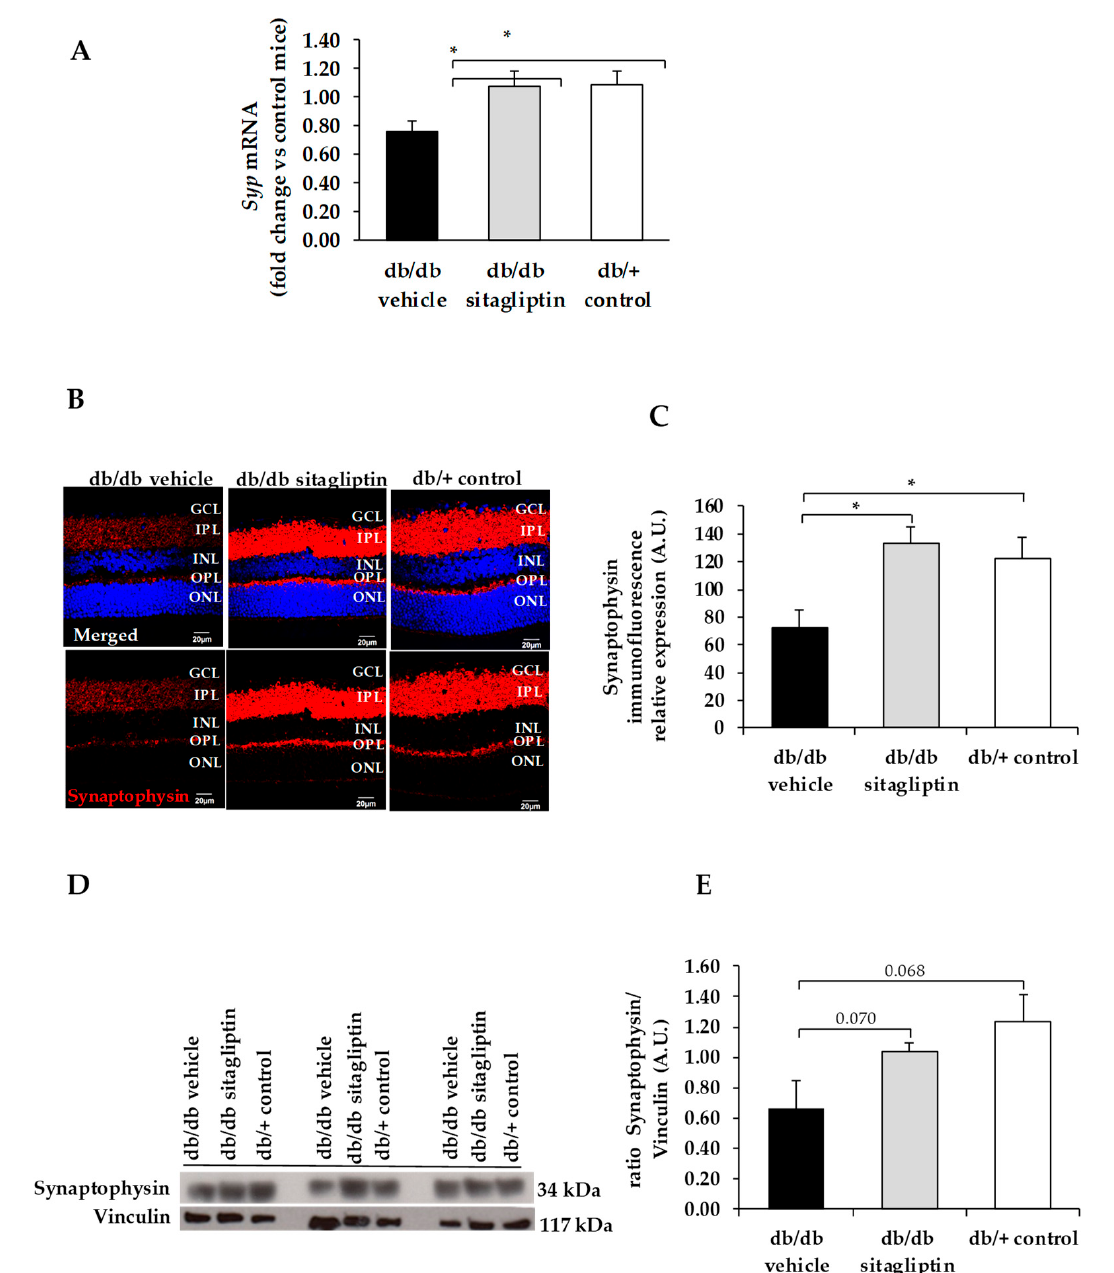
Figure 2. ( A ) Real-time quantitative RT-PCR analysis of synaptophysin gene (Syp) in db/db mice treated with vehicle (black bars), sitagliptin eye drops (grey bars), and in non-diabetic mice (white bars). ( B ) Immunofluorescence of synaptophysin (red) among representative samples of diabetic retinas of experimental groups. Hoechst staining (blue) was used for nuclei labeling. ONL: outer nuclear layer; OPL: outer plexifom layer; INL: inner nuclear layer; IPL: inner plexiform layer; GCL: ganglion cell layer. Scale bars, 20 µ m. ( C ) Quantification of synaptophysin immunofluoresence in diabetic mice treated with vehicle eye drops (black bars), sitagliptin eye drops (grey bars), and in non-diabetic retinas (white bars). ( D ) Western blot bands of synaptophysin and ( E ) Densitometric analysis in db/db mice treated with vehicle eye drops (black bars), sitagliptin eye drops (grey bars), and in non-diabetic mice retinas (white bars). Protein levels were normalized with vinculin. * p < 0.05.